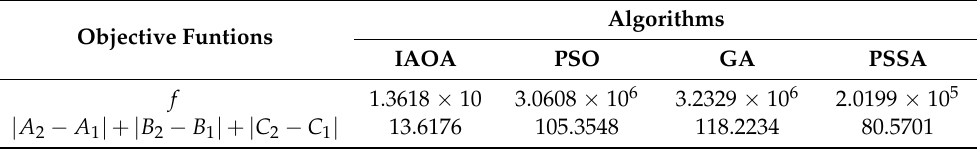
Table 19. Comparison of the experimental results for the IAOA, PSO, GA, and